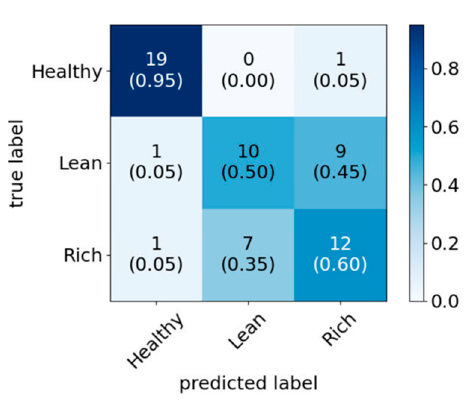
Figure 7. Model 1—confusion matrix for ignition timing variation data.